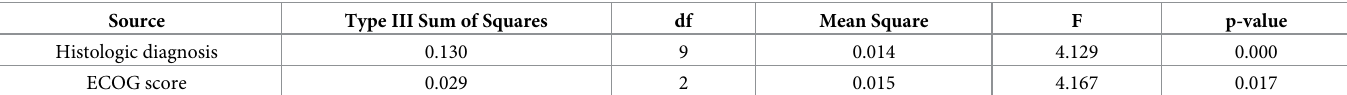
Table 4. Clinical multivariate data related to the methylation value of cg19810954 in ADARB1 in LUAD.